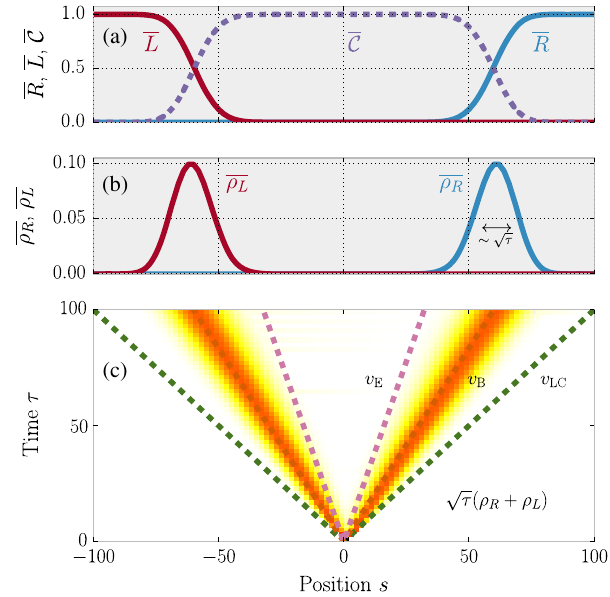
FIG. 2. Spreading of a one-site operator averaged over random s; τ Þ ( ρ s; τ Þ ) is the total weight unitary circuits. Note that ρ R ð L ð carried by Pauli strings with a right (left) endpoint at site s at time τ . Panel (c) shows the sum of these two functions (multiplied by ffiffiffi p τ to show the position of the front more clearly). Almost all the weight is carried by operators with endpoints at the two fronts propagating out from the initial site with speed v q 2 − 1 =q 2 þ 1 Þ . These fronts in turn broaden diffusively ffiffiffi B ¼ ð p τ in time as . The two other velocity scales, the light-cone velocity v and the entanglement velocity v [see Eq. (27)], are E LC < v < v also indicated, satisfying v . The values of ρ and E B R LC ρ after 100 layers of the circuit are shown in panel (b). Panel L ¯ R ¯ L (a) shows the integrated operator weights ð s Þ ( ð s Þ ), denoting the total weight left (right) of site s , along with the OTO commutator C ð s; τ Þ . The OTOC saturates to 1 inside the front and has the value 1 = 2 exactly at τ ¼ s=v B